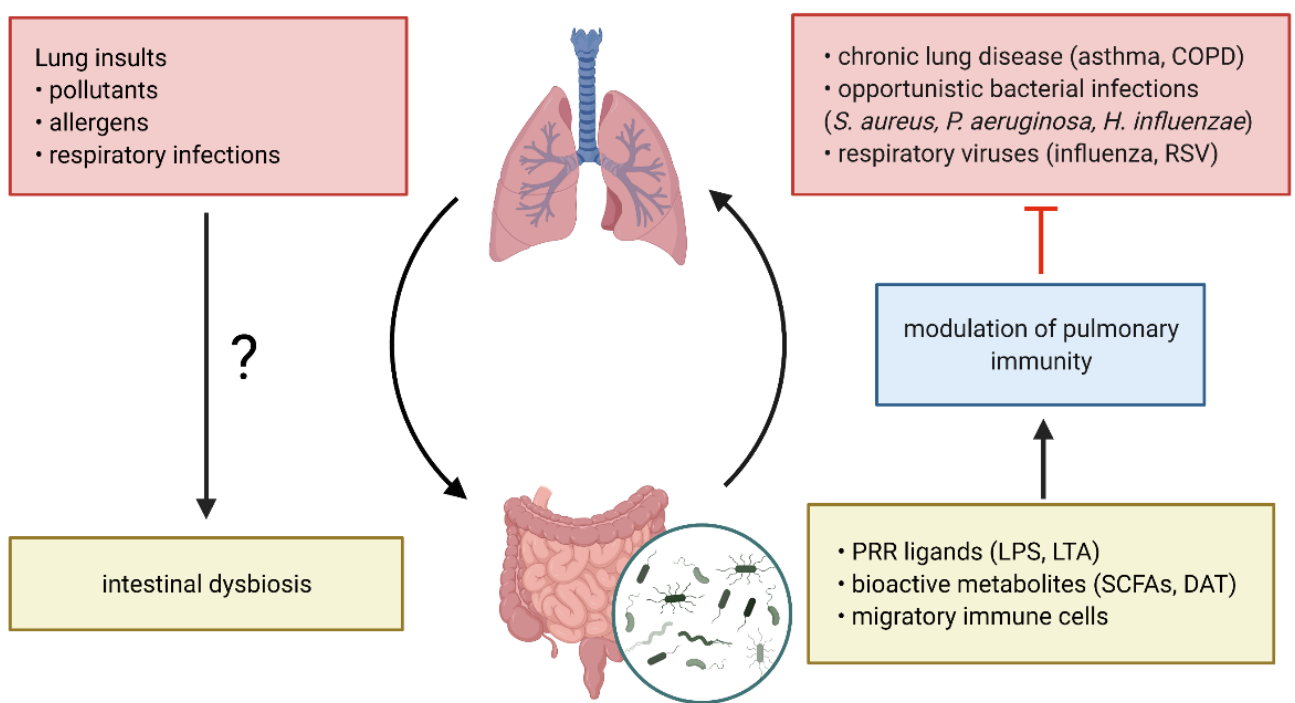
Figure 1. The gut-lung axis in respiratory disease. The continuous cross-talk between the gut and lung is facilitated by structural bacterial pattern recognition receptor (PRR) ligands including bacterial cell wall components, gut commensal-derived metabolites and migratory immune cells. Bacterial PRR ligands and metabolites are released in the circulation and bind to their respective receptors on pulmonary immune and/or epithelial cells, thereby modulating immunity to respiratory pathogens during chronic lung disease. Pulmonary insults can induce intestinal dysbiosis, however the underlying mechanisms are not well understood. COPD, chronic obstructive pulmonary dis- ease; RSV, respiratory syncytial virus; PRR, pattern recognition receptor; LPS, lipopolysaccharide; LTA, lipoteichoic acid; SCFAs, short-chain fatty acids; DAT, desaminotyrosine. Figure created with BioRender.com. 3. Microbiome-Based Prevention and Intervention Strategies in Respiratory Disease lating the composition or activity of the resident microbiome by supplementation with or inanimate bacterial preparations (postbiotics) has been proposed as a novel prevention depletion of opportunistic pathogens by antibacterial monoclonal antibodies or bacterio- phages has shown promising results in preventing bacterial pneumonia in at-risk patients and both will be further discussed below and are summarized in Figure